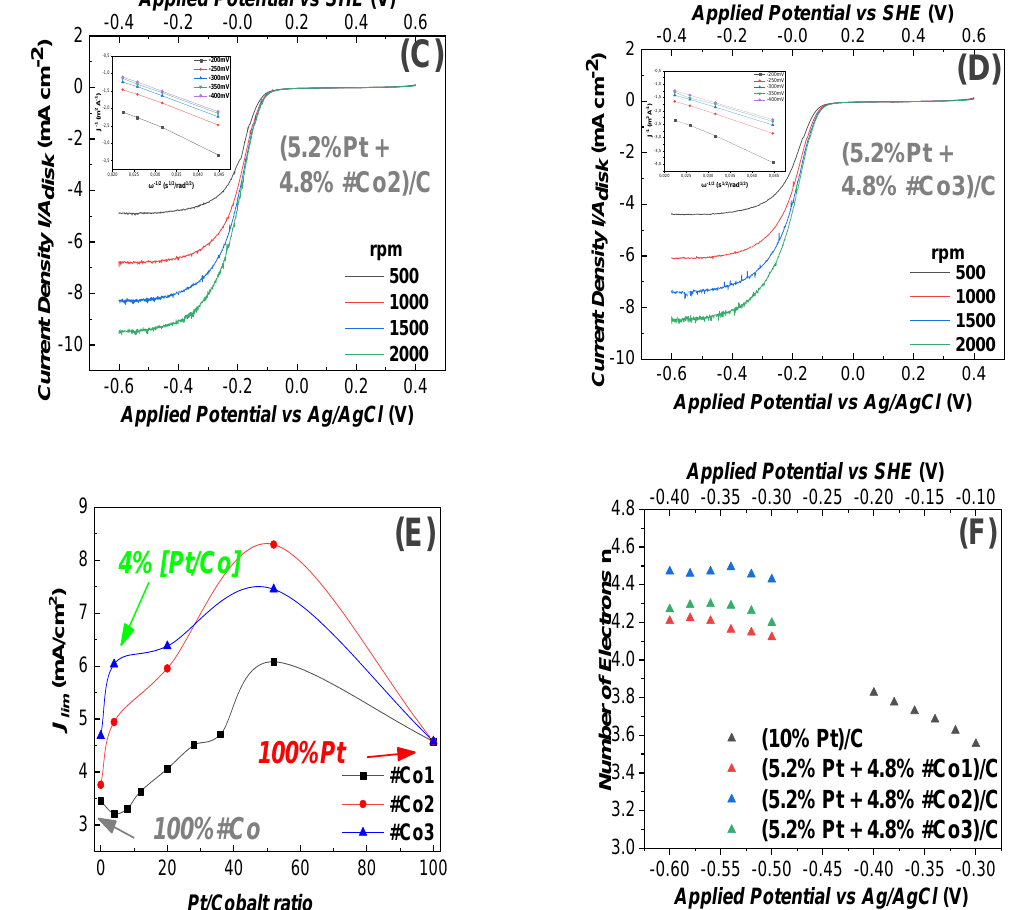
Figure 5. Linear Voltammograms for ORR, recorded using a Glassy-Carbon rotating electrode, loaded with nanocatalysts, in O 2 saturated 0.1 M NaOH solution (pH = 13.4). The potential scan rate was 10 mV/s, ( A ) electrode containing 10% Pt/C (reference). In B, C, D all electrodes contained (5.2% Pt 4.8% FSP-Cobalt oxide/C). ( B ) #Co1-based electrode, ( C ) #Co2-based electrode, ( D ) #Co3-based electrode, ( E ) Limiting current density versus Pt/Cobalt ratio on the working electrodes, ( F ) Electron transfer number (n), estimated using Equation (7) for the data at 1500 rpm. Insets in A, B, C, D : Elovich plots where J lim vs. [rotation frequency] −1/2 .